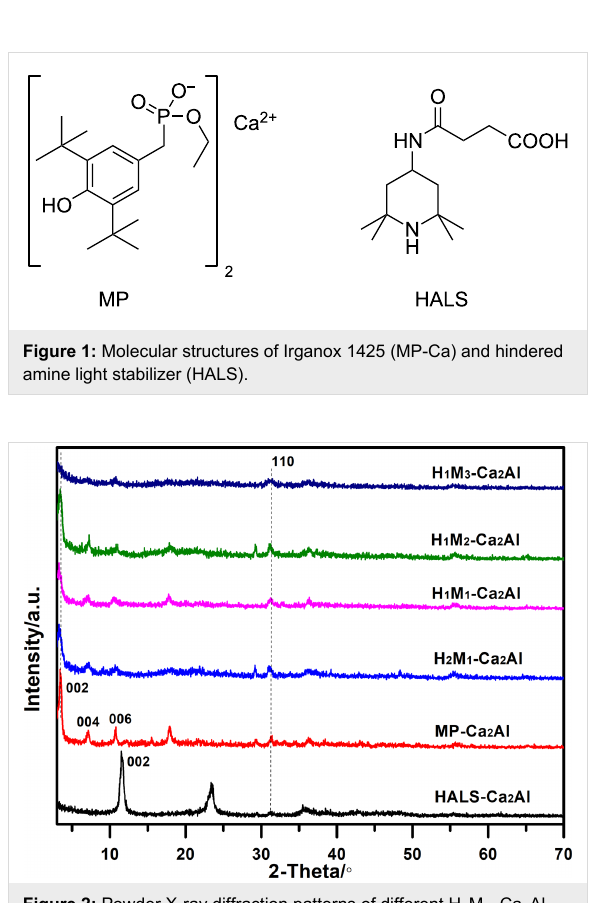
sheet [22]. The (002) reflection peaks of HALS-Ca 2 Al and MP-Ca 2 Al are located at 11.5° ( d 002 = 0.77 nm) and 3.4° ( d 002 = 2.52 nm), respectively. Simultaneously, for LDHs co-intercalated with HALS and MP (H 2 M 1 -Ca 2 Al, H 1 M 1